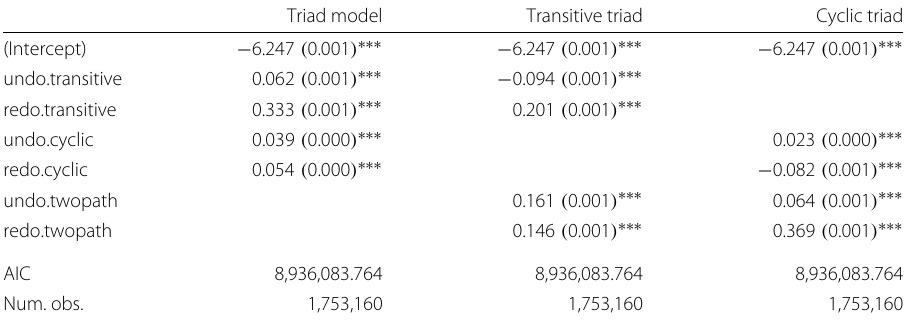
Table 10 Explaining dyadic redo by past undo and redo on transitive and cyclic two-paths Triad model Transitive triad Cyclic triad (Intercept) − 6.247 ( 0.001 ) ∗∗∗ − 6.247 ( 0.001 )